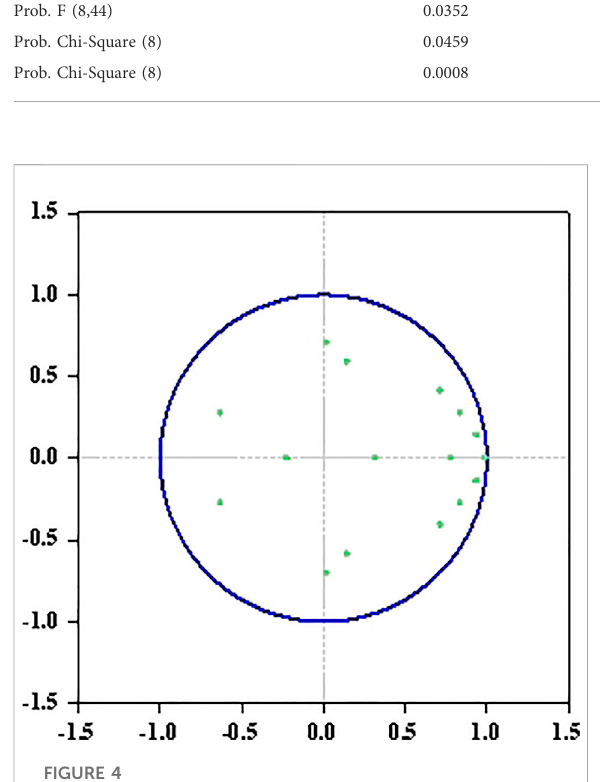
FIGURE 4 Inverse roots of AR characteristic